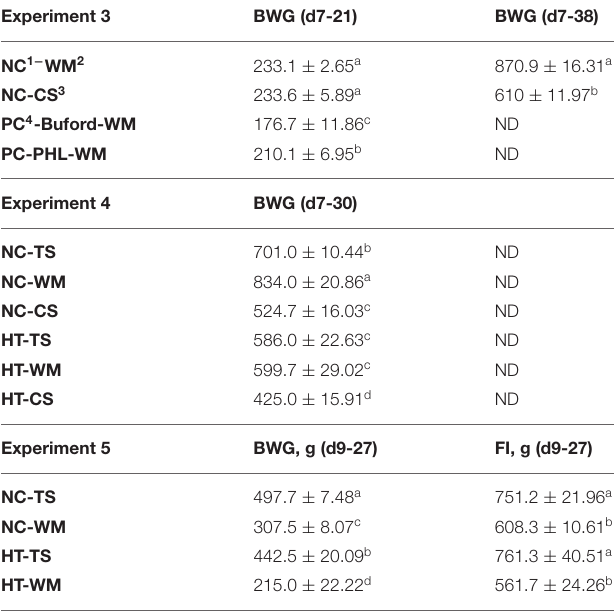
TABLE 3 | Evaluation of body weight gain (BWG) or feed intake (FI) of turkeys inoculated with two different isolates of Histomonas meleagridis (Buford or PHL) and fed different experimental diets in validation experiments 3, 4 and 5.